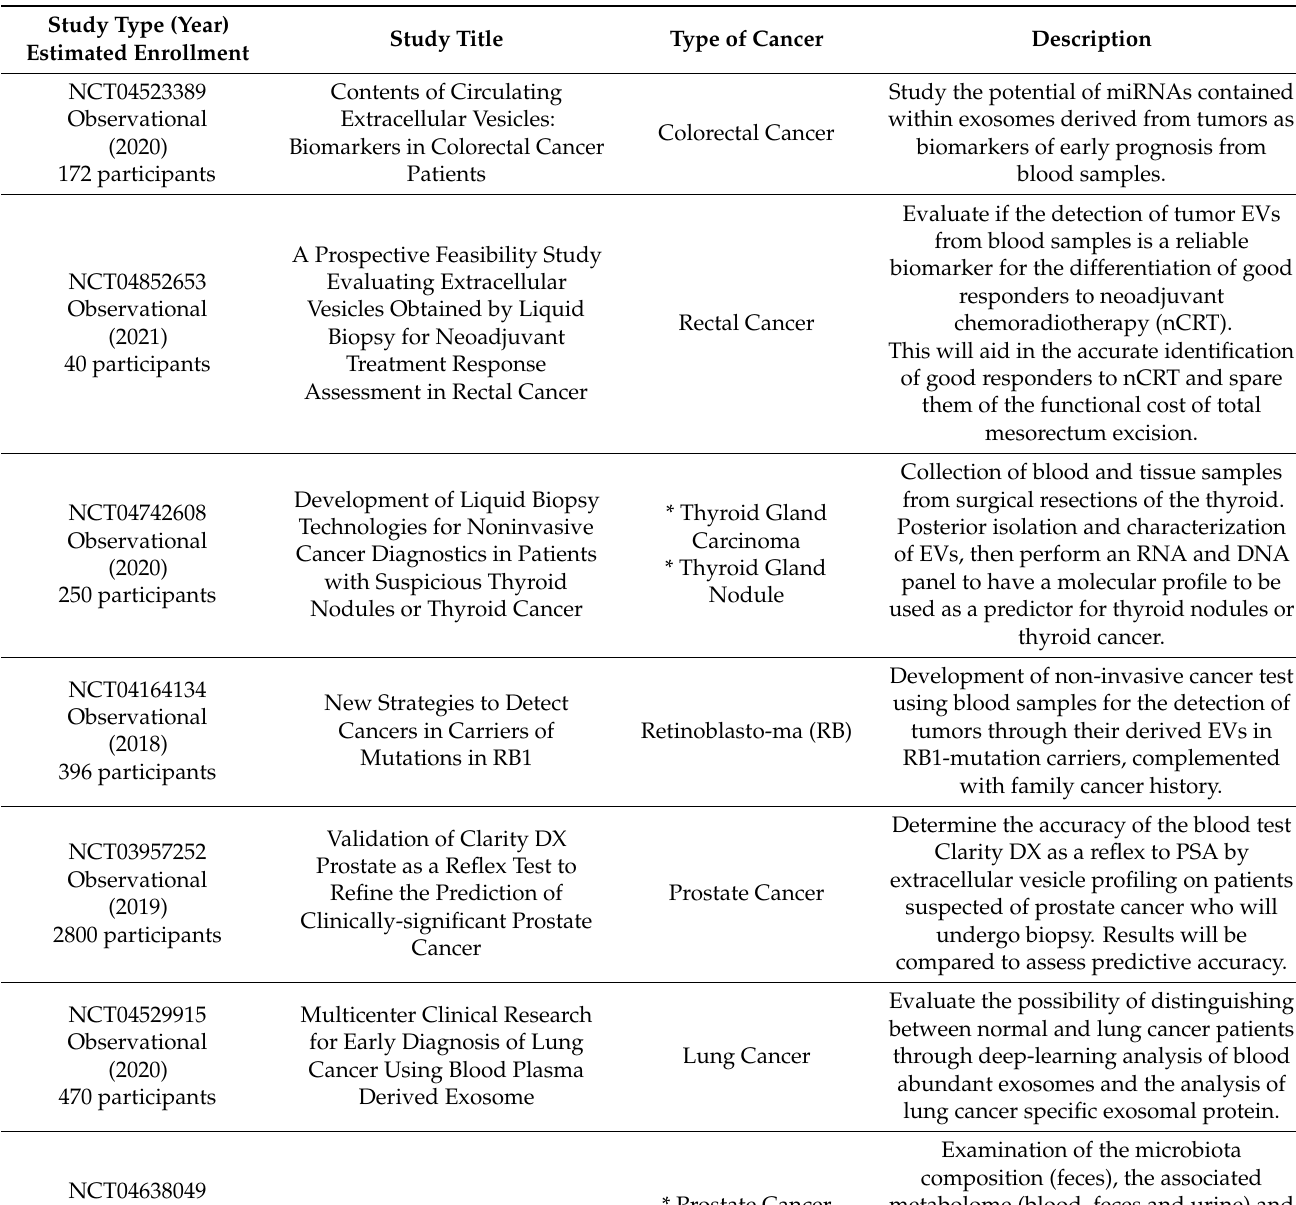
Table 4. Ongoing clinical trials registered in ClinicalTrials.gov (accessed on 1 November 2021) utilizing extracellular vesicles as biological indicators and the description of the circumstances under which they are